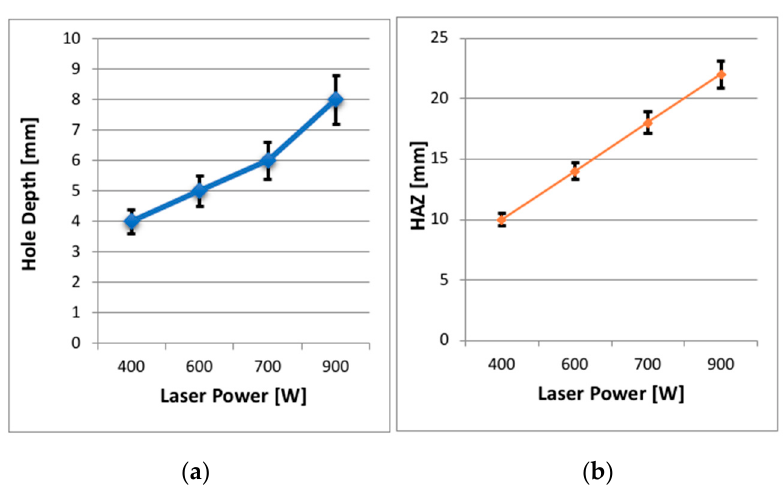
Figure 8. Effect of laser power at a constant scanning speed of 10 mm/s on: ( a ) hole depth; ( b ) heat ‐ Figure 8. E ff ect of laser power at a constant scanning speed of 10 mm / s on: ( a ) hole depth; ( b ) heat-a ff ected zone affected zone (HAZ).